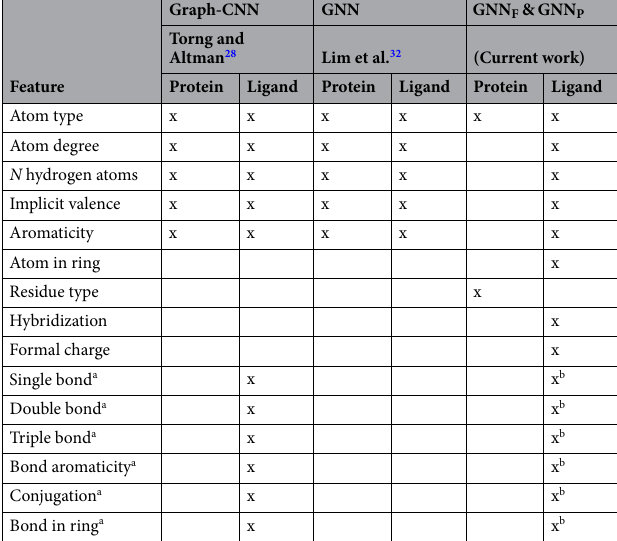
Table 1. Features associated with each atom in the protein and ligand for the Graph-CNN model described by Torng et al. 28 , the GNN described by Lim et al. 32 , and GNN F and GNN P described in this contribution. Features are associated with the atom unless otherwise noted. a Bond feature; b bond feature is indirectly considered by a corresponding atom-level feature that captures the same physical property.